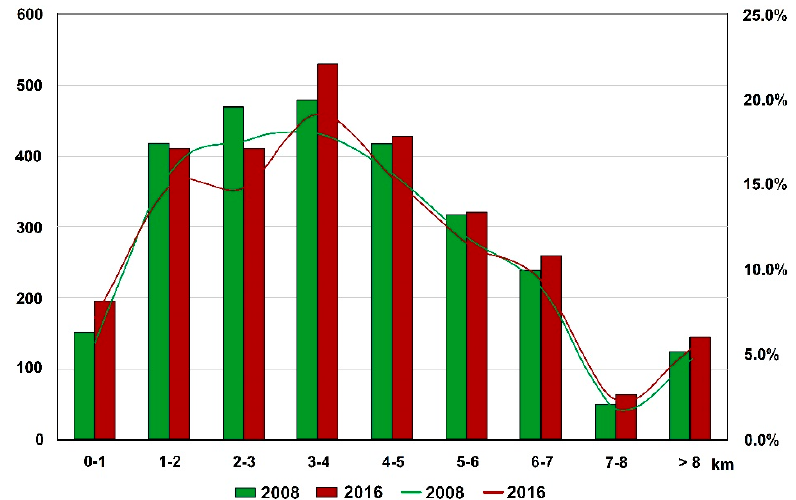
Figure 4. The number of low-technology industrial entities and their share in total depending on the distance from the city center in 2008–2016 (sourced by authors).